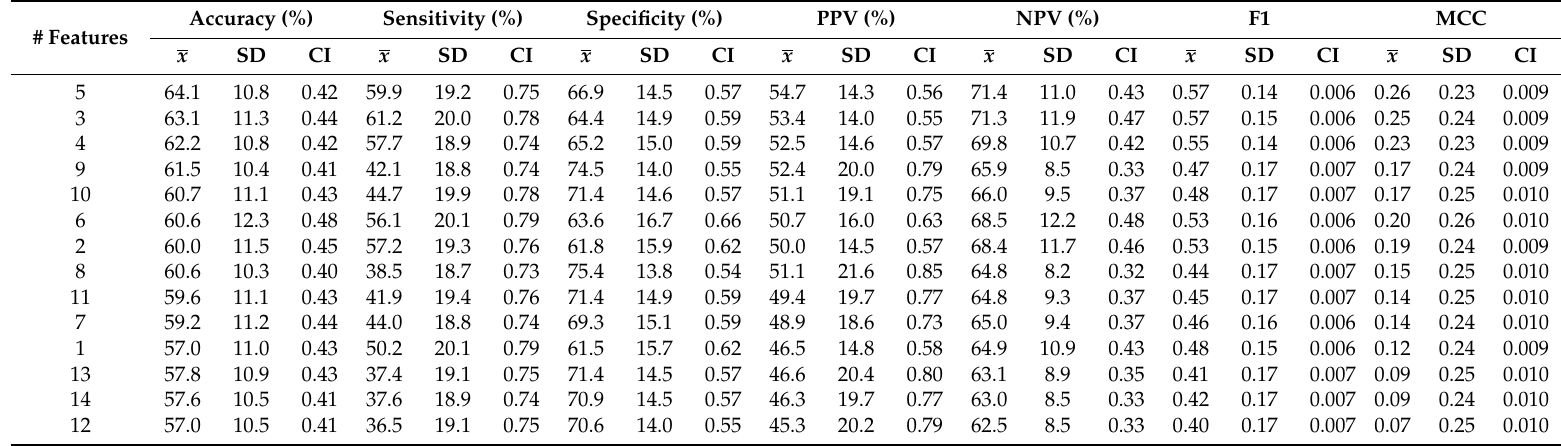
Table 5. Most frequently occurring (MFO) feature subsets for straight-walking section results and 3NN classifier using 2500-iteration random-shuffle-split cross validation (2500-RSS), ordered by ranked performance. PPV: positive predictive value, NPV: negative predictive value, MCC: Matthews correlation coefficient, x : mean, SD: standard deviation, CI: 95% confidence interval.